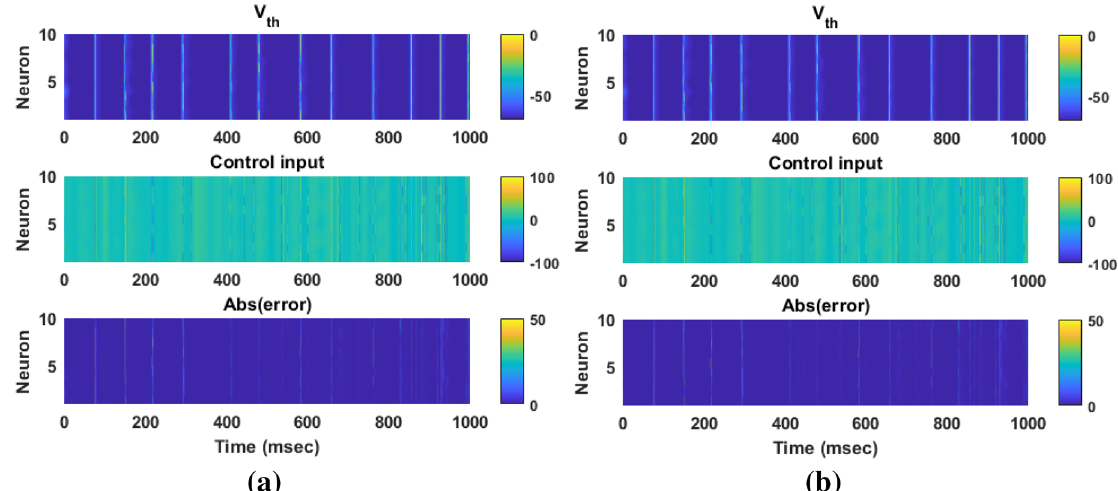
Figure 10. Typical results of the membrane potential, control input, and absolute tracking error for individual cells of the TH populations under 50% time-varying system parameters and external disturbances using ( a ) AFTSMC ( b ) AFSMC.